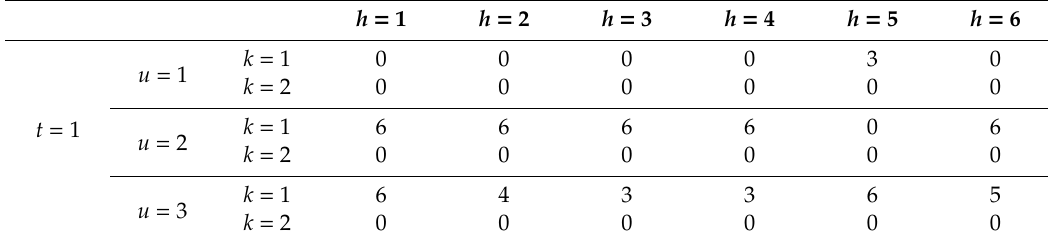
Table 25. Required number of each vehicle between distributor “ d = 2” and hospitals during time period t = 1.